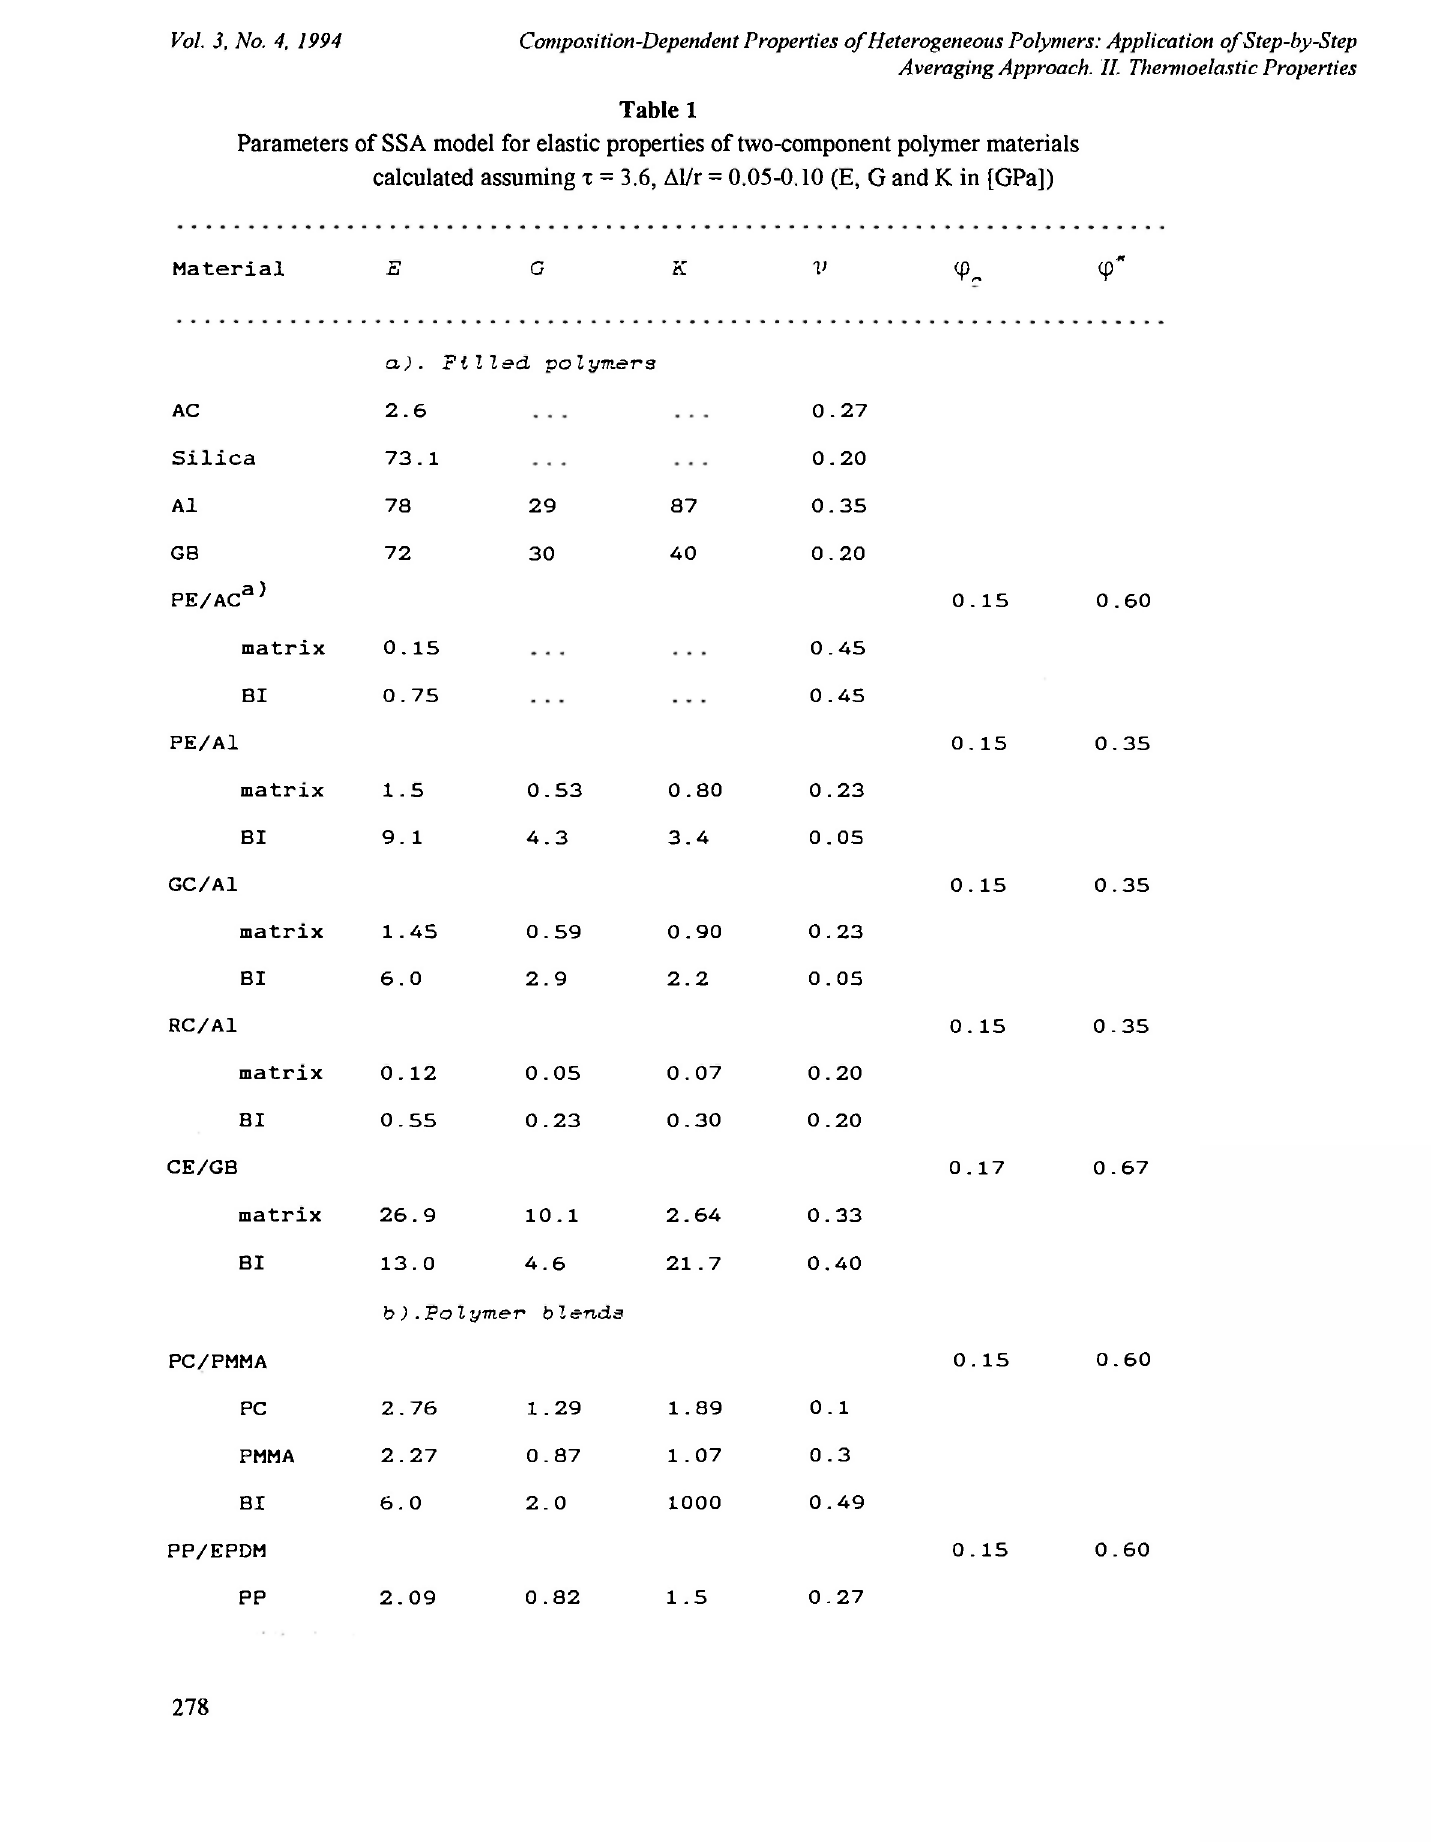
Parameters of SSA model for elastic properties of two-component polymer